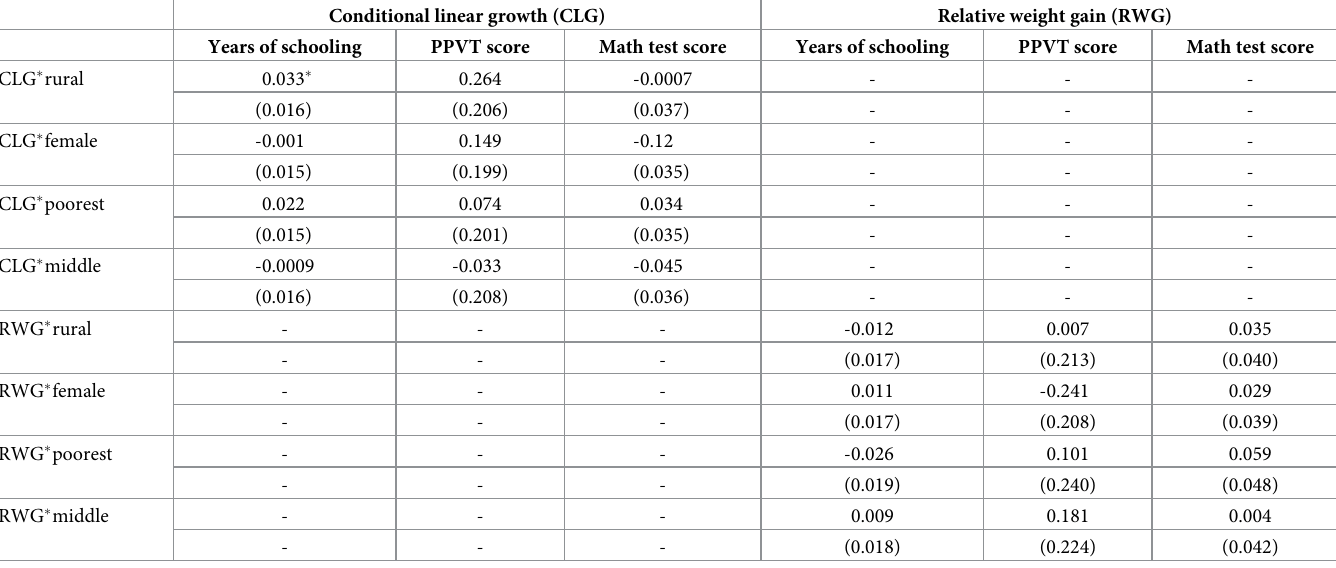
Table 4. Heterogeneous effects of conditional linear growth and relative weight gain on educational outcomes @ .